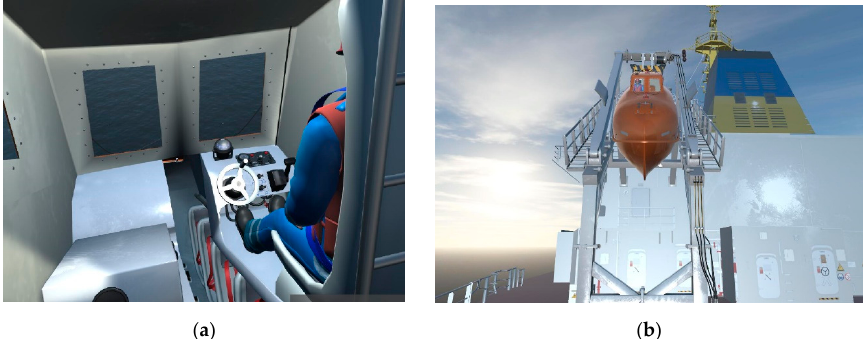
Figure 25. Scene of virtual human operating lifeboat ( a ) and lifeboat moving on the skid ( b ) in a ship’s lifesaving training system.